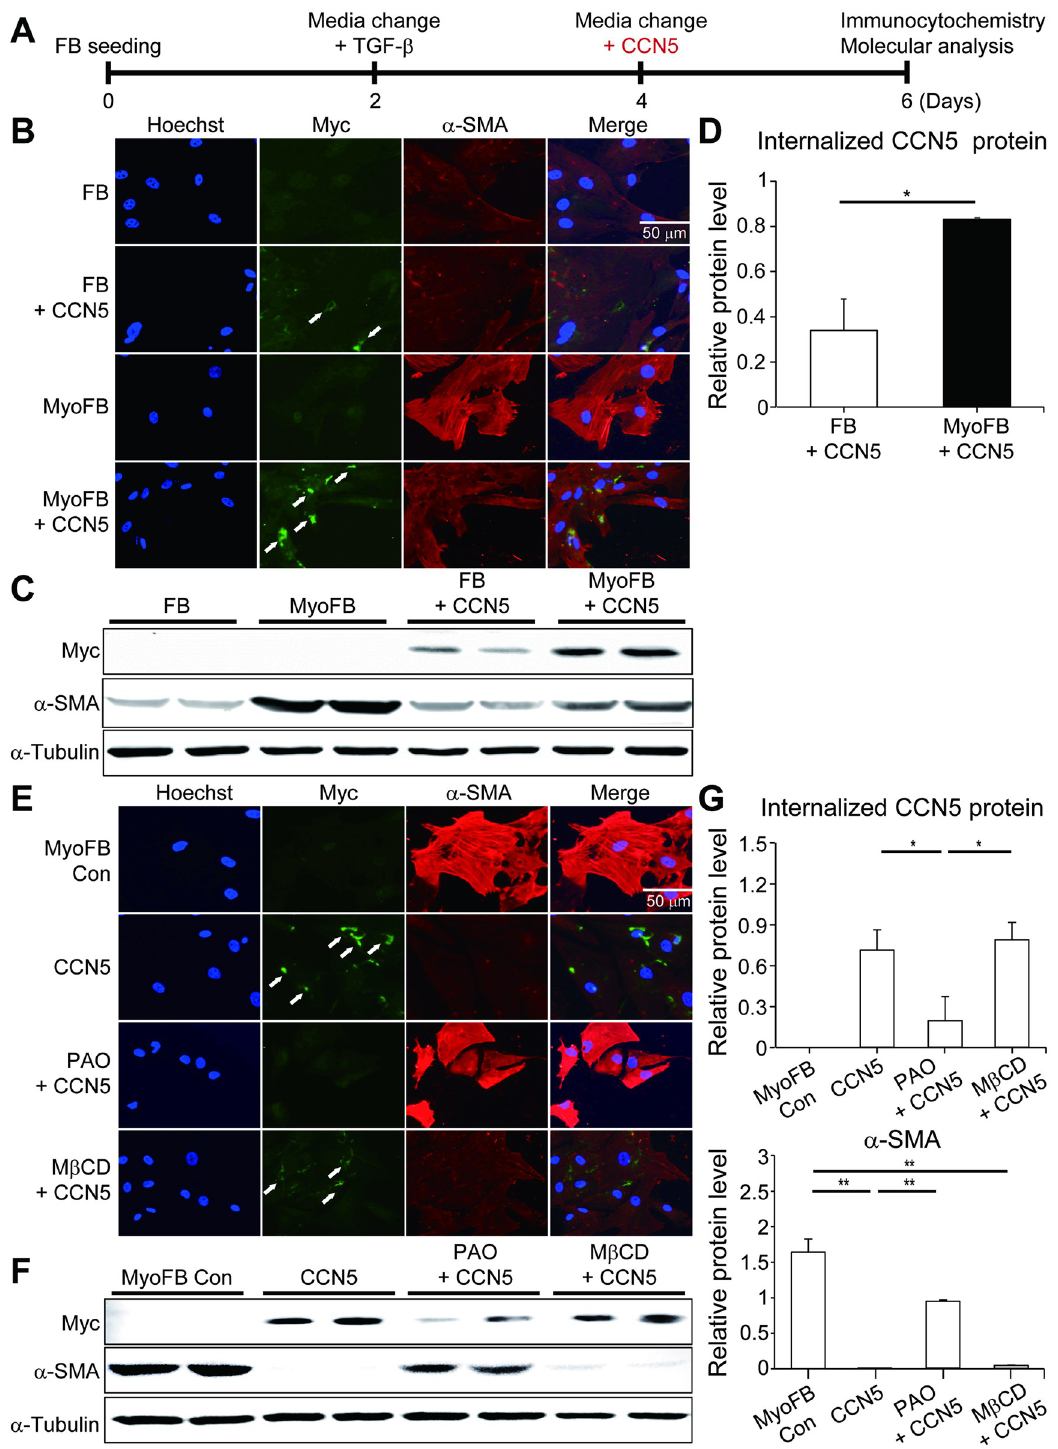
Fig 1. CCN5 is internalized mainly via clathrin-mediated endocytosis. (A) The experimental scheme. FBs were trans- differentiated to MyoFBs by treatment with TGF- β (10 ng/mL). FBs and MyoFBs were treated with purified CCN5 protein (20 nM) for 2 days and then immunostained with anti-Myc (CCN5) and - α -SMA antibodies. Nuclei were stained with Hoechst dye. (B) Representative images are shown. Weak to strong immunogenicity of CCN5 was observed in the majority of the cells. White arrows indicate strong CCN5 signals in cells. (C) Whole cell lysates (30 μ g) obtained from FBs and MyoFBs were immunoblotted with